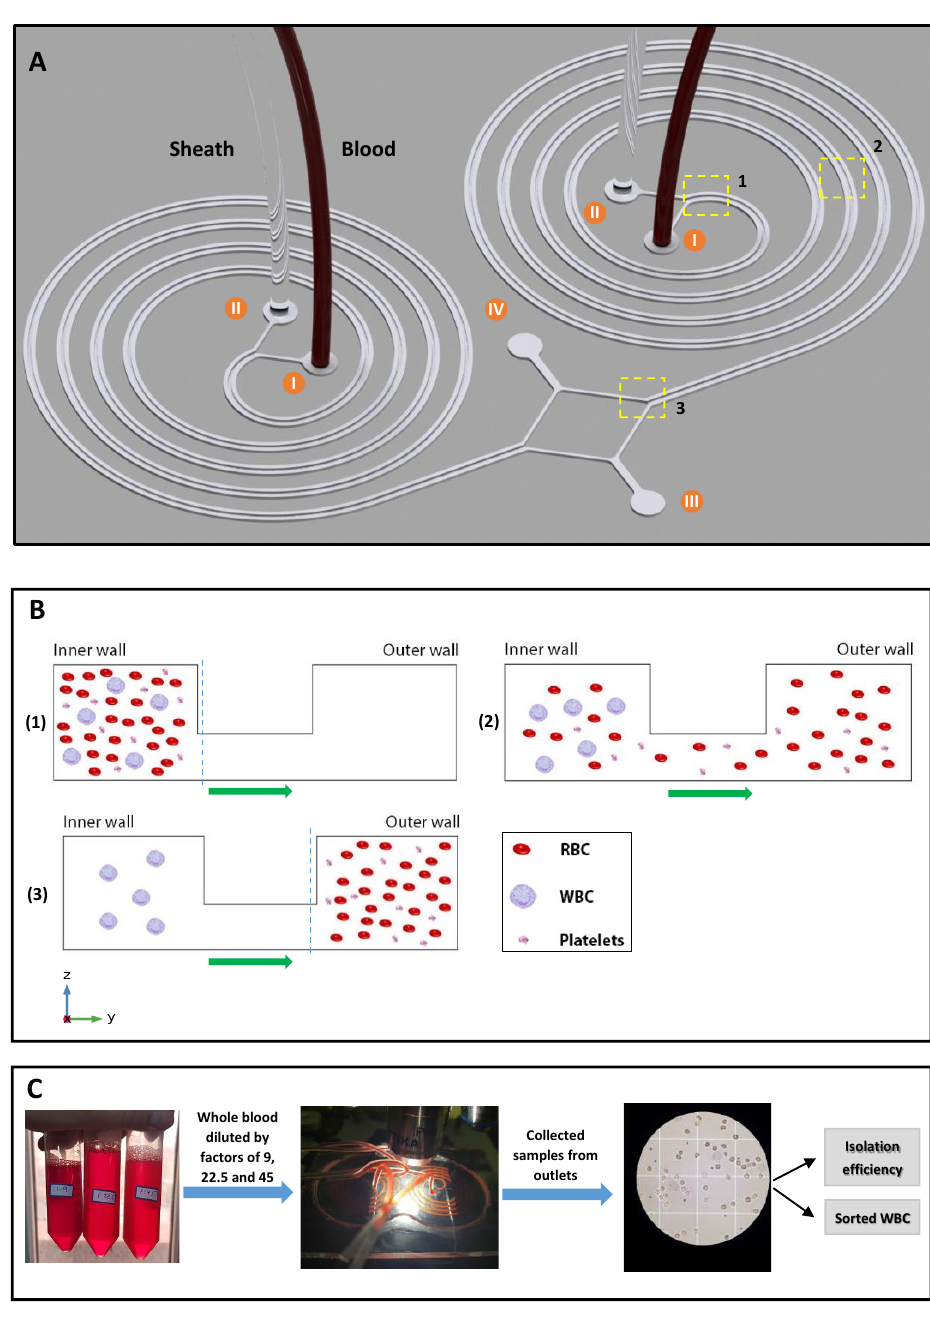
Figure 4. ( A ) 3D schematic of the proposed spiral microchip in this study. The design includes two parallel U-shaped cross-section spiral microchannels that consist of: (I) two inner inlets for the injection of blood samples, (II) two outer inlets for the injection of sheath fluid, (III) shared outer outlet for the extraction of RBCs and platelets, and (IV) shared inner outlet for the extraction of WBCs. ( B ) Larger blood cells, i.e., WBCs, affected by dominant inertial forces are focused along the inner microchannel wall. In comparison, smaller blood cells, i.e., RBCs and platelets, are forced to migrate toward the outer microchannel section by the effect of the secondary flow (flow direction is shown in green arrows), which in turn stops the smaller cells from getting back to the inner microchannel section. ( C ) The overall process of WBC sorting and enumeration. Blood cell count is done using a Neubauer chamber, and the resulting WBC isolation efficiency is calculated using the fractional ratio of blood cells in specific outlets to the total count of blood cells in both outlets.